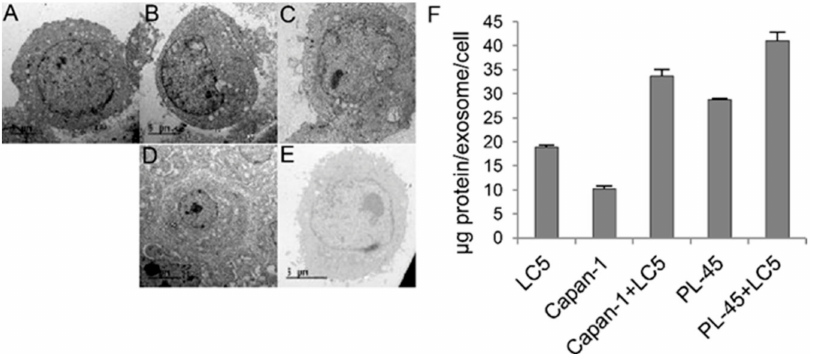
Figure 5. Representative images by transmission electron microscopy (TEM) of cells growing for 72 h. LC5 cells growing at monoculture ( A ). Capan-1 cells in monoculture ( B ). PL-45 cells in monoculture ( C ). Capan-1 and LC5 cells in coculture ( D ). PL-45 and LC5 cells in coculture ( E ). Quantification of protein by exosome in monoculture and coculture conditions ( F ). Scale bar indicates 5 µ